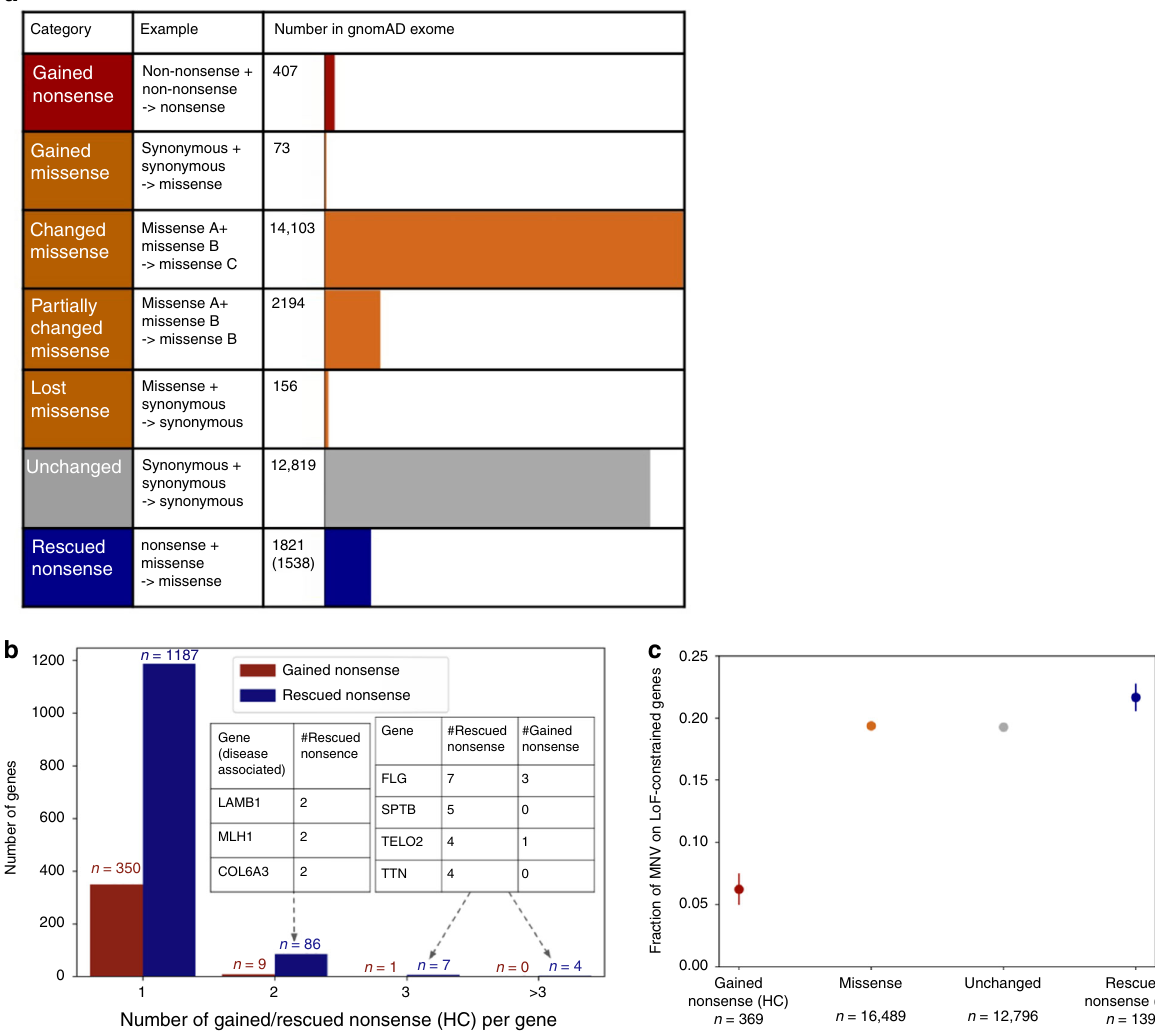
Fig. 2 Functional impact of MNVs. a The number of MNVs in the gnomAD exome data set per MNV category. Of the 1821 rescued nonsense mutations, 1538 are rescued in all individuals that harbor the original nonsense mutation and are used for the analysis in ( b ) and ( c ). Gained and rescued nonsense MNVs were further fi ltered to HC pLoF in ( b ) and ( c ). b The number of gained/rescued nonsense mutations per gene, and examples of disease-associated genes with two or more gained/rescued nonsense mutations. c The fraction of each category of MNV found in a set of 3941 constrained genes (top